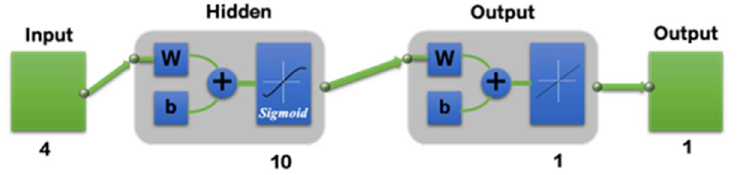
Figure 12. BP neural network illustration with Sigmoid hidden neurons and linear output neurons.